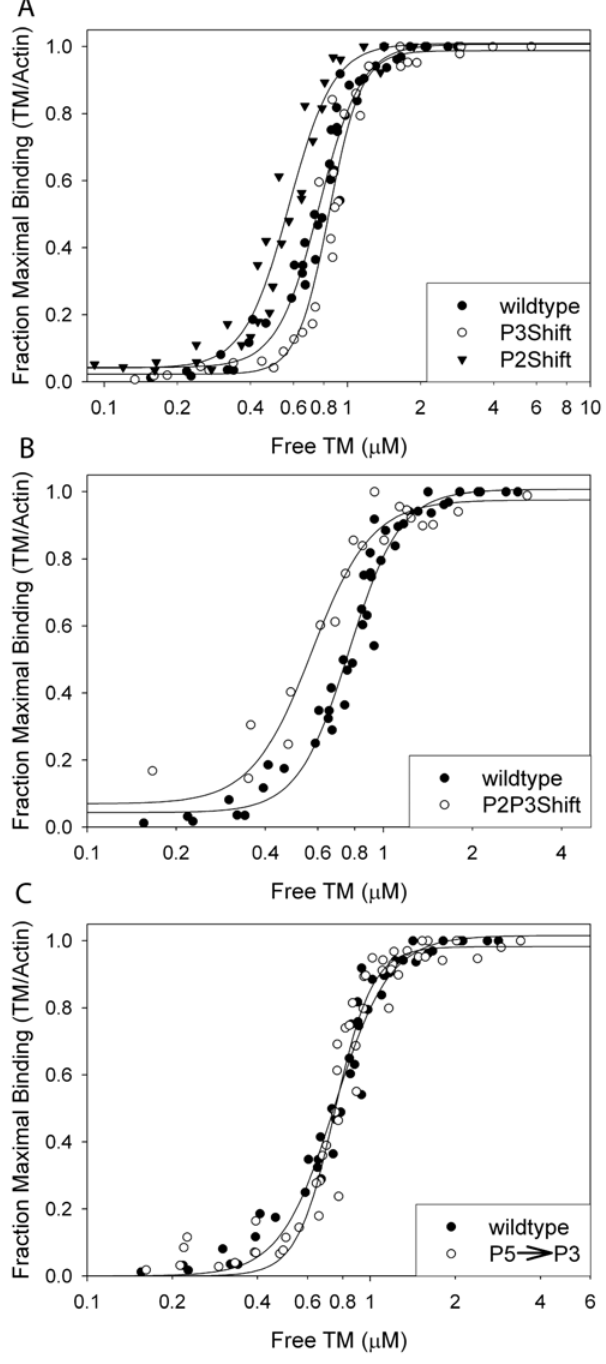
Figure 6. The effect the mutations on the actin affinity measured by cosedimentation with F-actin. Binding to filamen- tous actin. Tropomyosin (0.1–10 m M, depending on the tropomyosin) and 0.12–12 m M troponin T 70–170 [44] were combined with 5 m M actin and sedimented at 20 u C in 250 mM NaCl, 10 mM TrisHCl, pH 7.5, 2 mM MgCl 2 , and 0.5 mM DTT. Stoichiometric binding of 1 tropomyosin: 7 N actins is represented by the 1.0 fraction of maximal binding. The N N , wildtype; # , apparent K app s are reported in Table 2. A. Symbols: , wildtype; # , P2P3Shift. C. Symbols: , P3Shift, . , P2Shift. B. Symbols: wildtype; # , P5 R P3. The mutations affect the affinity and cooperativity of binding.